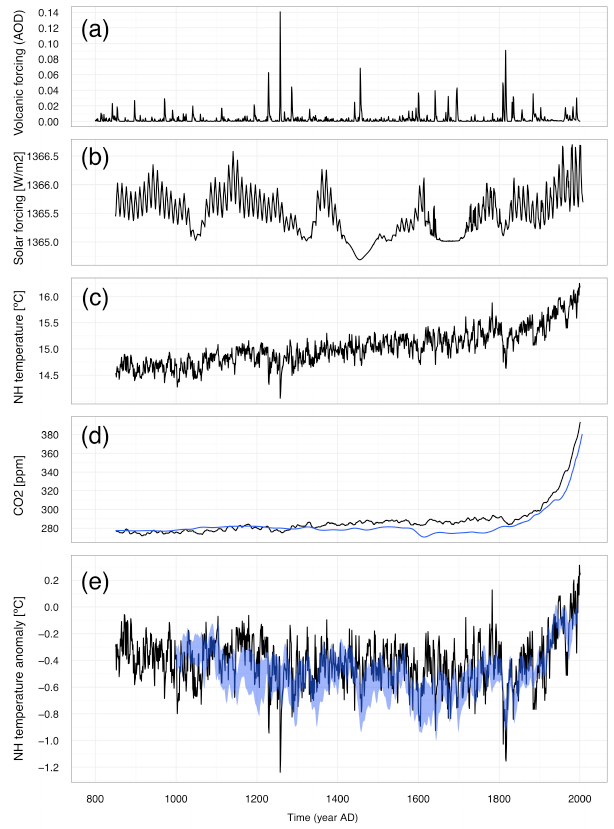
2 Fig. 12. The (a) volcanic and (b) solar forcing, (c) annual mean surface air temperature in the Northern Hemisphere, (d) model- predicted (black) and reconstructed (blue) atmospheric CO 2 con- centration, and (e) detrended time series of mean annual surface air temperature anomaly (anomaly from the 1971–2000 mean). The blue shading represents the range of temperature reconstruction be- tween the 20th and 80th percentile by Frank et al.